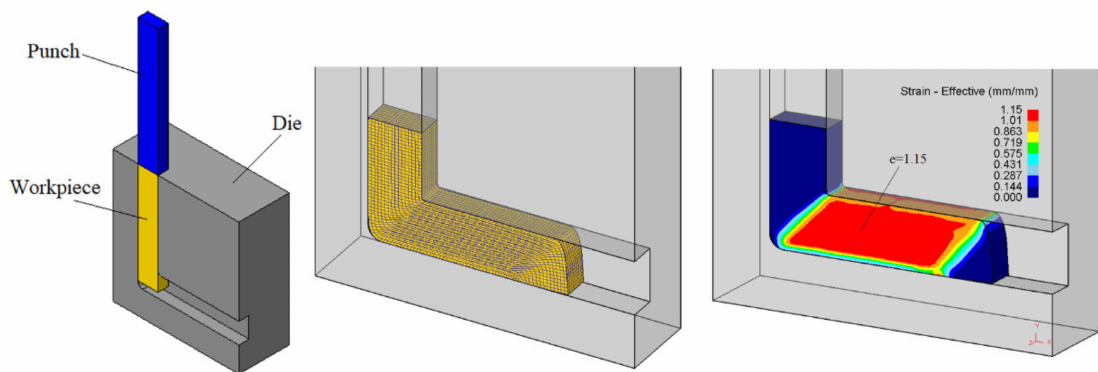
Figure 21. Schematic illustration of ECAP.